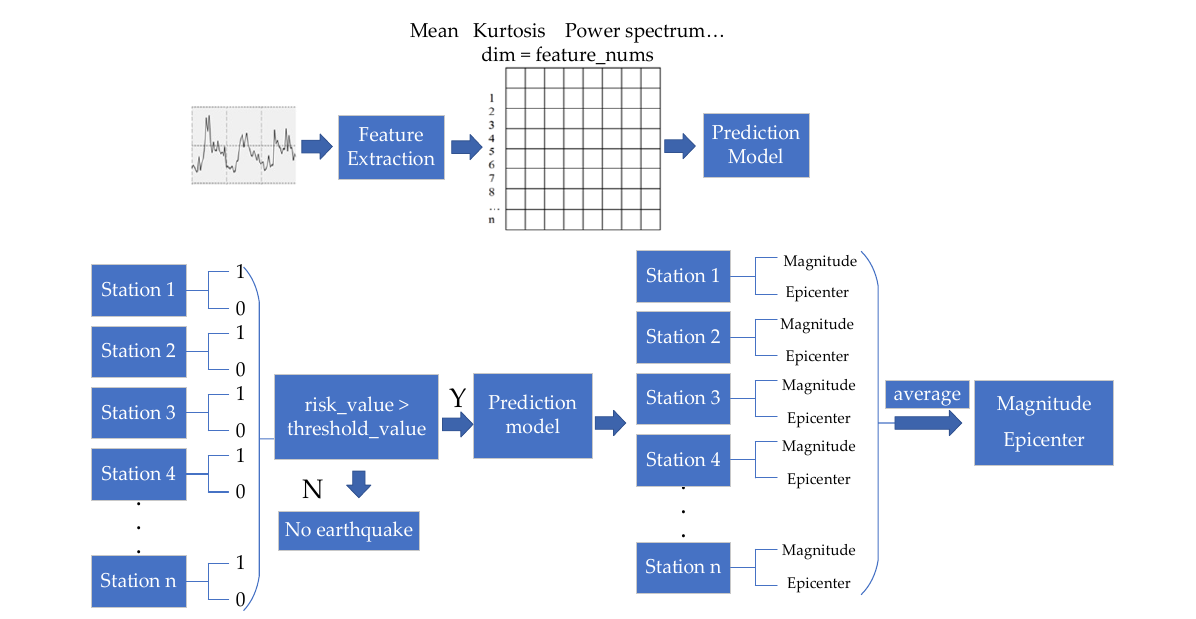
Figure 11. Decision process of earthquake-prediction model.